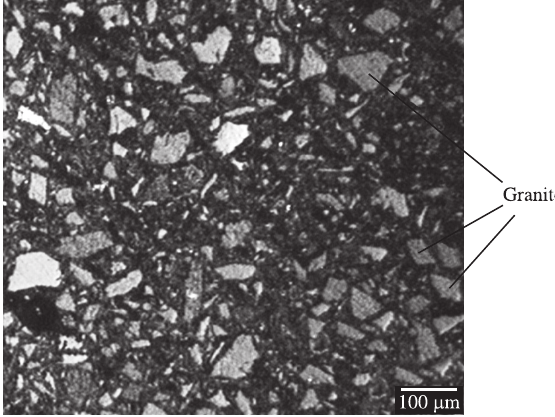
Figure 8. B12, PS test frequency spectrum.